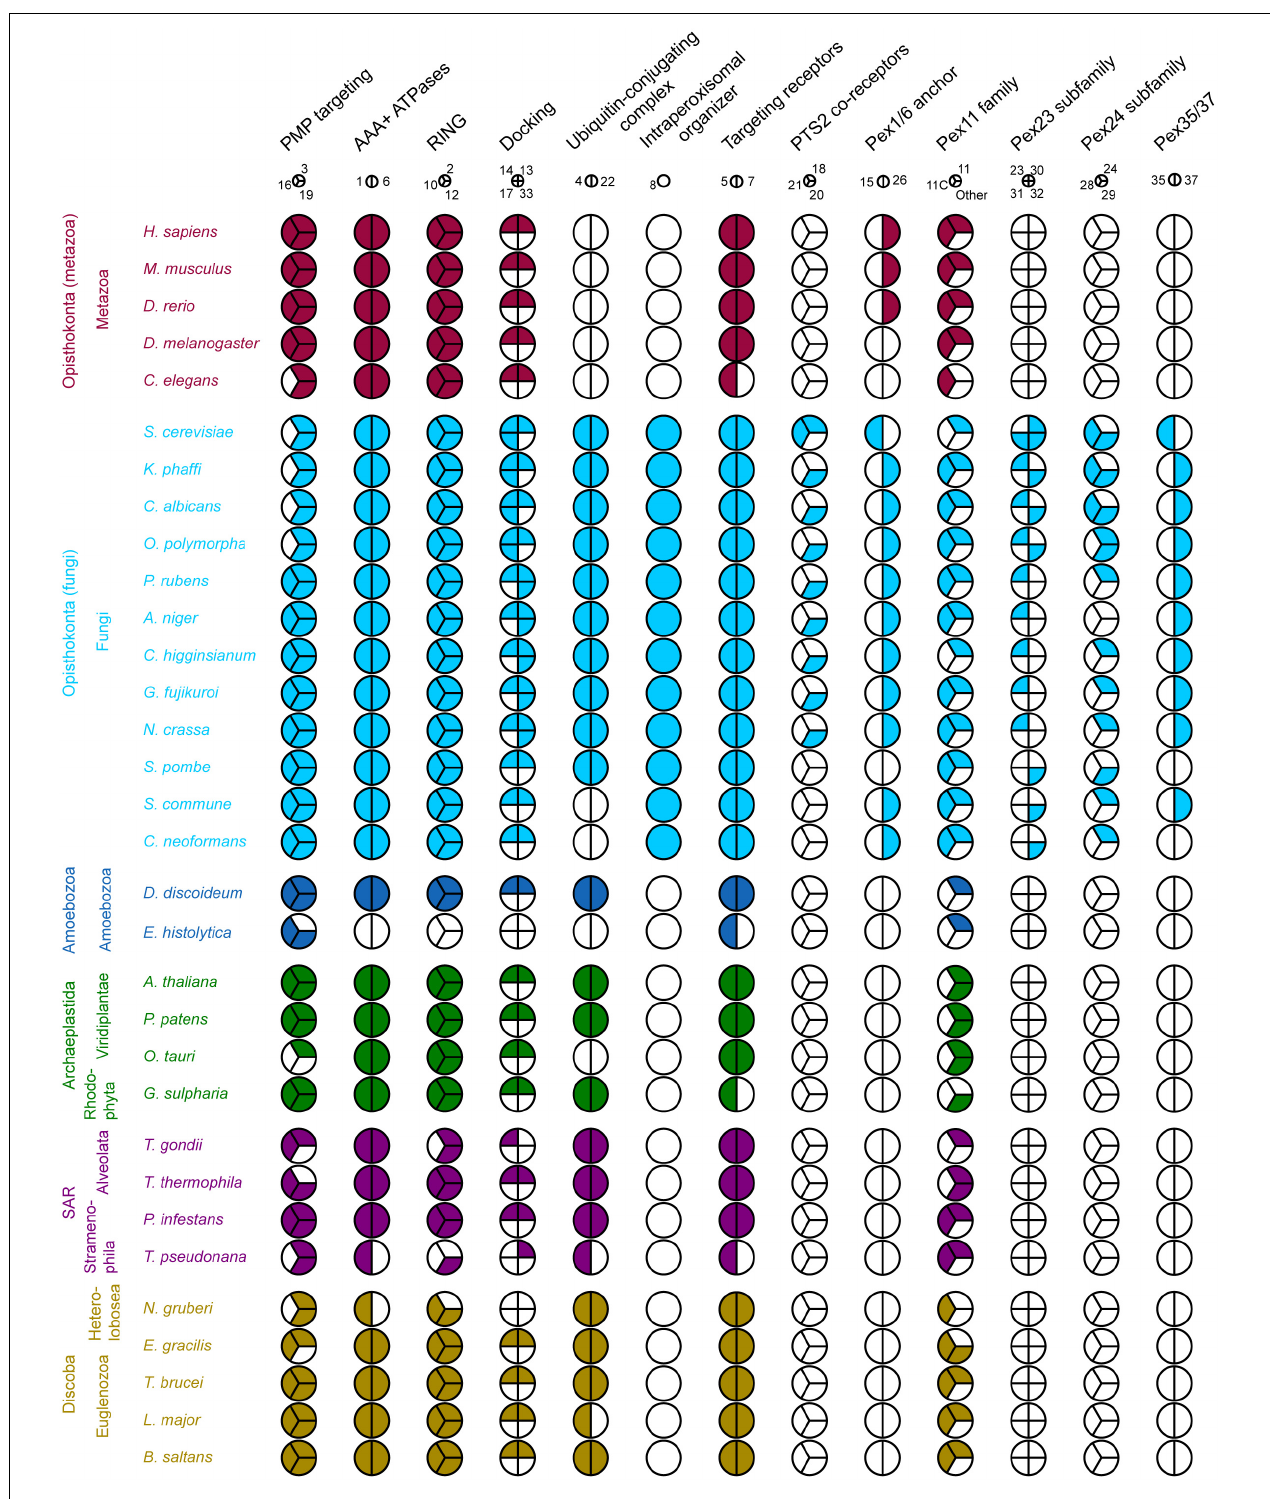
FIGURE 2 | Coulson plot demonstrating the presence (filled) or absence (empty) of PEX protein orthologs in 32 eukaryotic proteomes. PEX proteins are divided into functional groups (columns) including homologous and non-homologous proteins, represented by a pie. Every wedge represents a PEX protein, with the exception of the Pex11 family, where each wedge represents a main group. The PEX11 group contains among others fungal PEX11/25/27/34/36 and mammalian PEX11 α / β . The PEX11C group includes fungal PEX11C and mammalian PEX11 γ . Pex11 family proteins that do not belong to the either of these groups are placed in “Other.” Organisms are grouped by eukaryotic supergroup (color-coded for clarity) and kingdom. PEX proteins are designated by their number.